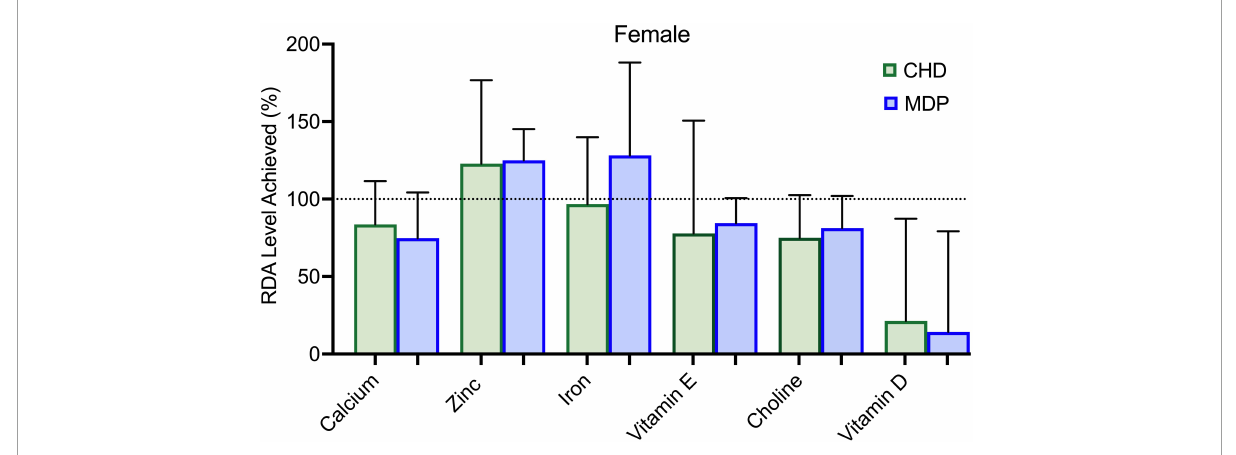
FIGURE3 Micronutrient intake of females compared to RDA for the Mediterranean diet pattern (MDP) and Canada’s Habitual Diet Pattern